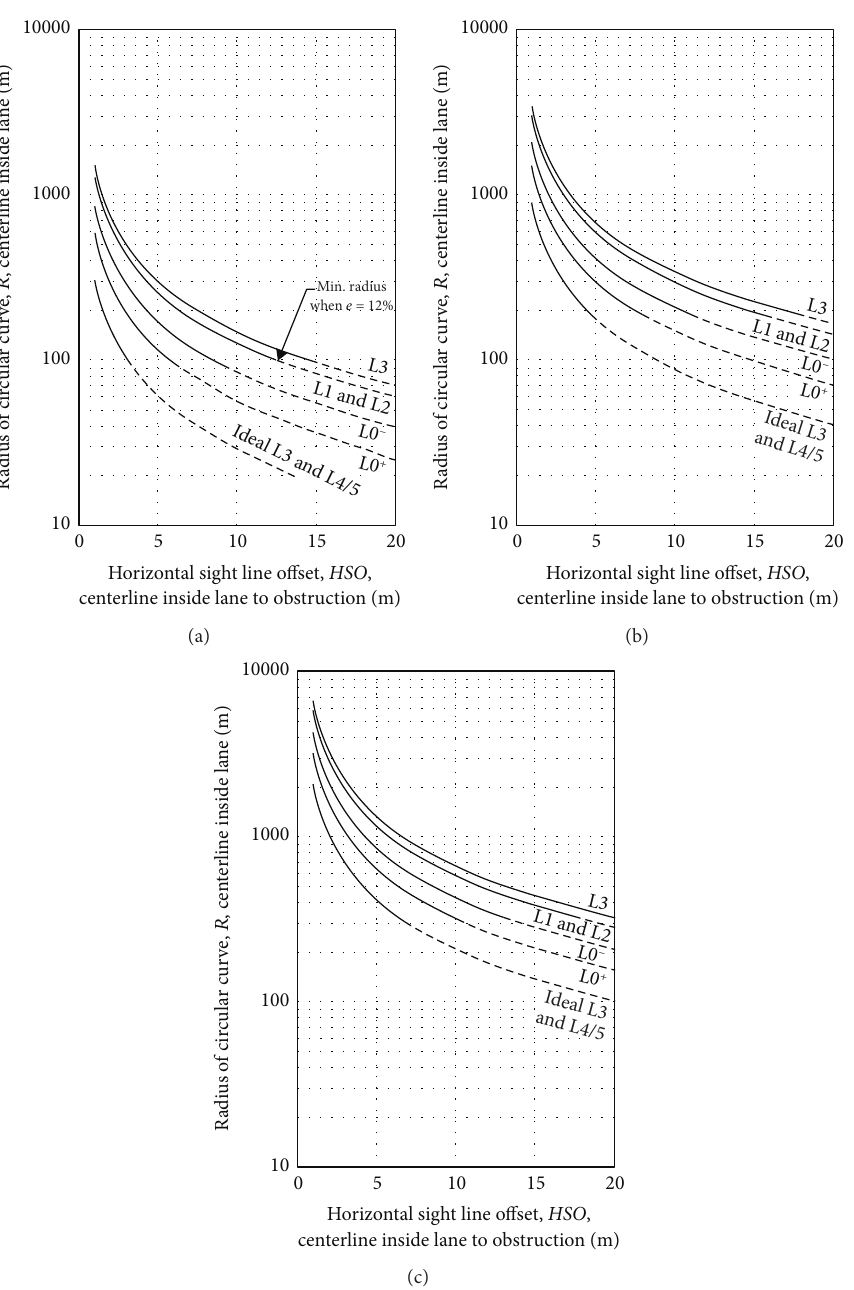
Figure 4: Required horizontal sight line offsets for all scenarios to provide stopping sight distances on horizontal curves: (a) V � 60 km/h; (b) V � 80km/h; (c) V �